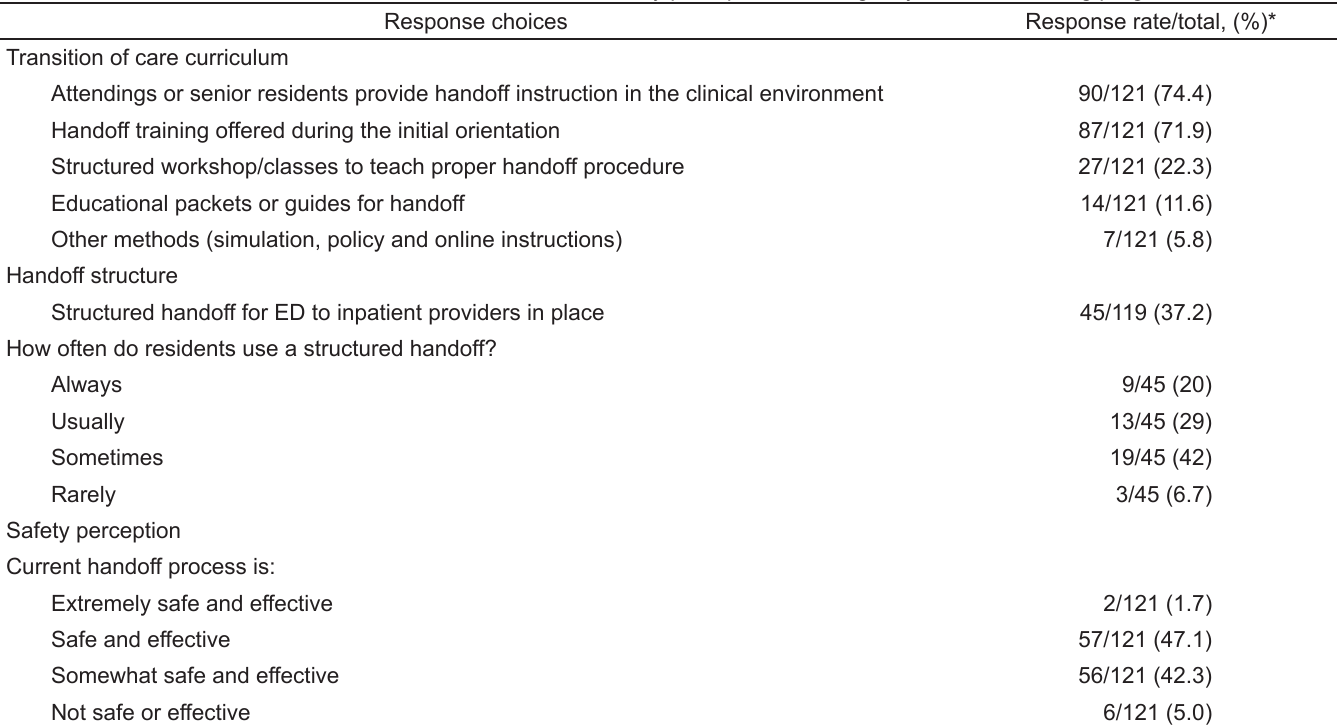
Table 1. Transition of care curriculum, handoff structure, and safety perception in emergency medicine training programs.